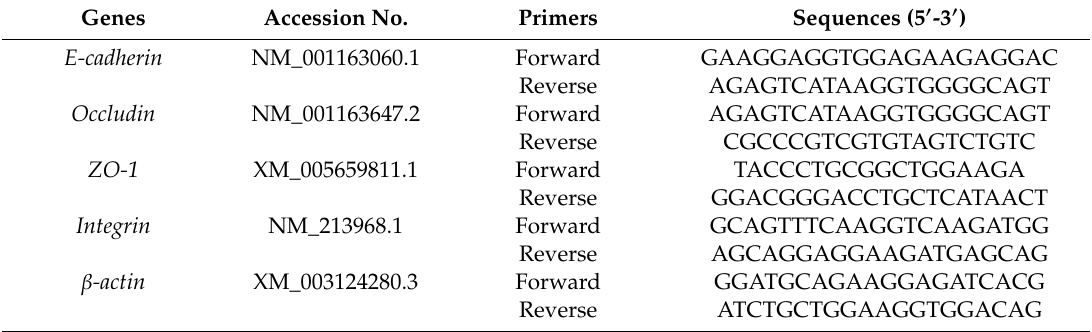
Table 1. Primers used for real-time quantitative PCR.